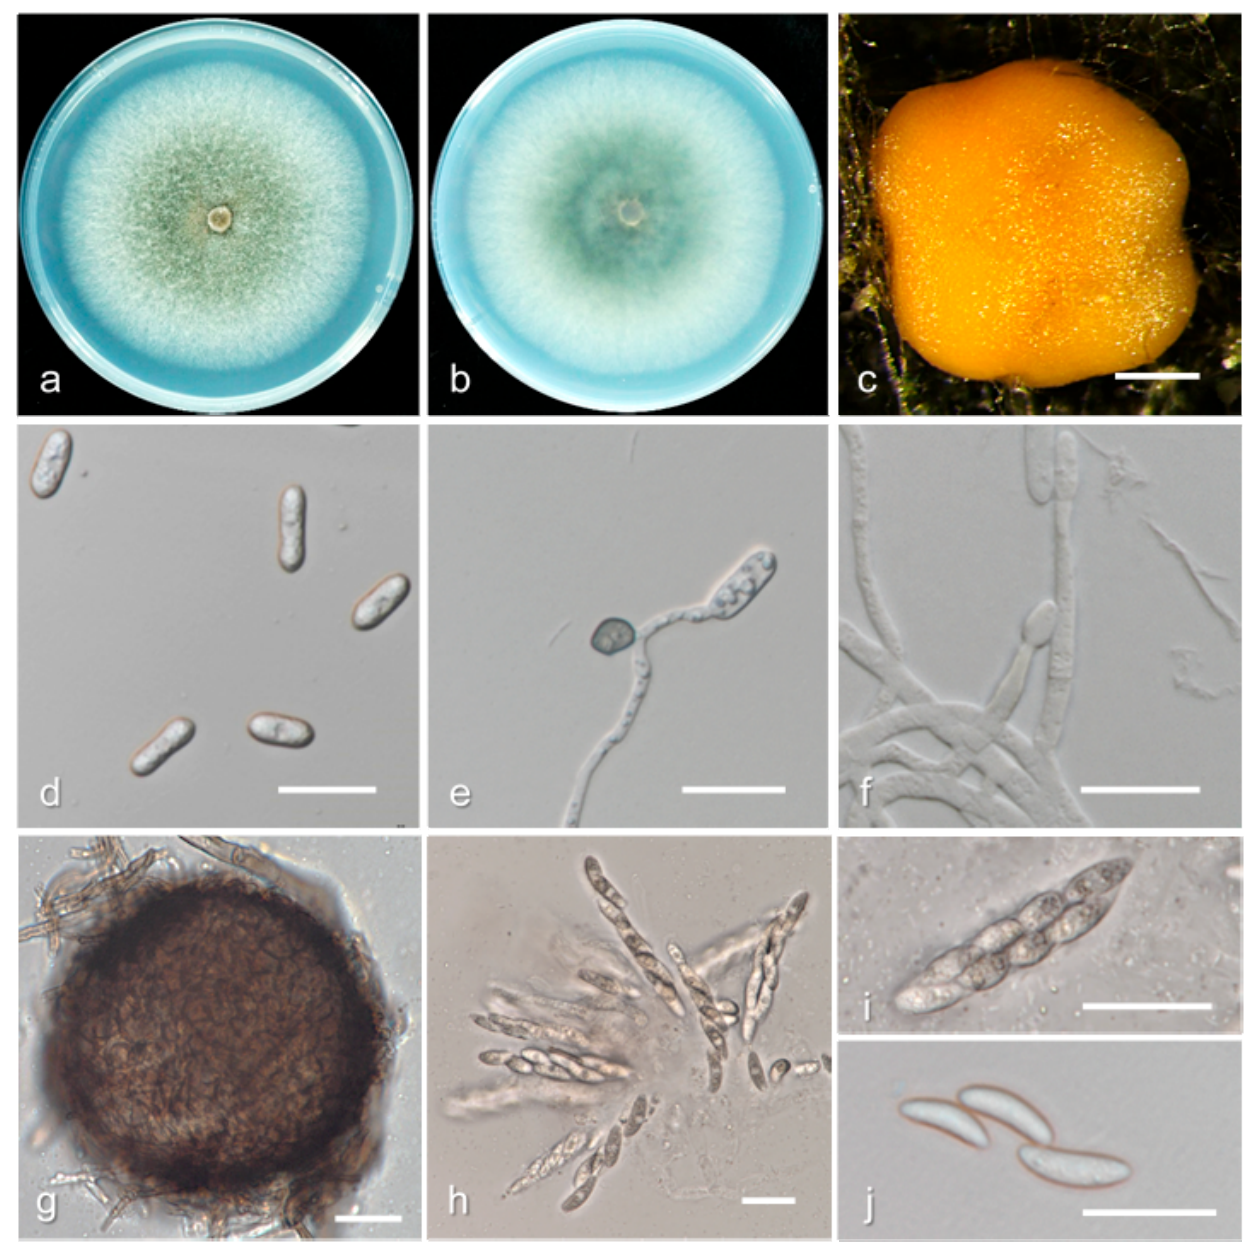
Figure 11. Biological characteristics of Colletotrichum fructicola . ( a , b ) Front and back view of six-day-old PDA culture; ( c ) conidiomata; ( d ) conidia; ( e ) appressoria; ( f ) conidiophores; ( g ) ascomata; ( h , i ) asci; ( j ) ascospores (( a – e ) isolate GDHY 10-1; ( f – j ) isolate GDSG 1-1). Scale bars: ( c ) = 200 µ m; ( d – j ) = 20 μ m.